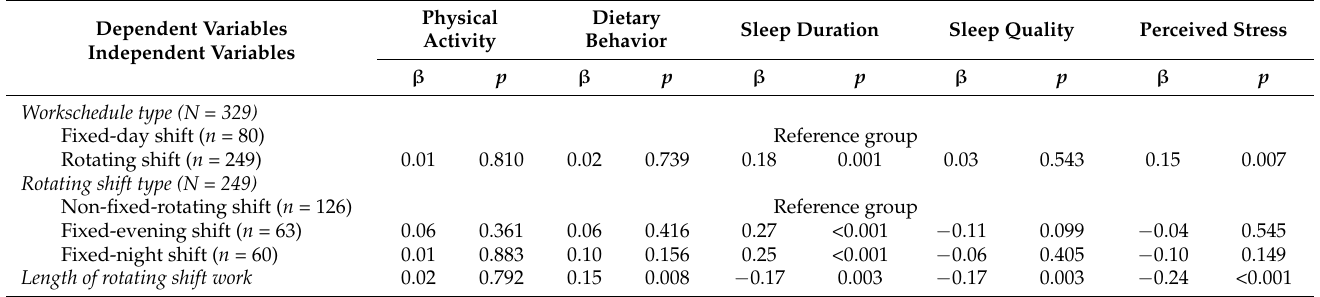
Table 5. Associations between work schedule characteristics and lifestyle patterns via multiple linear